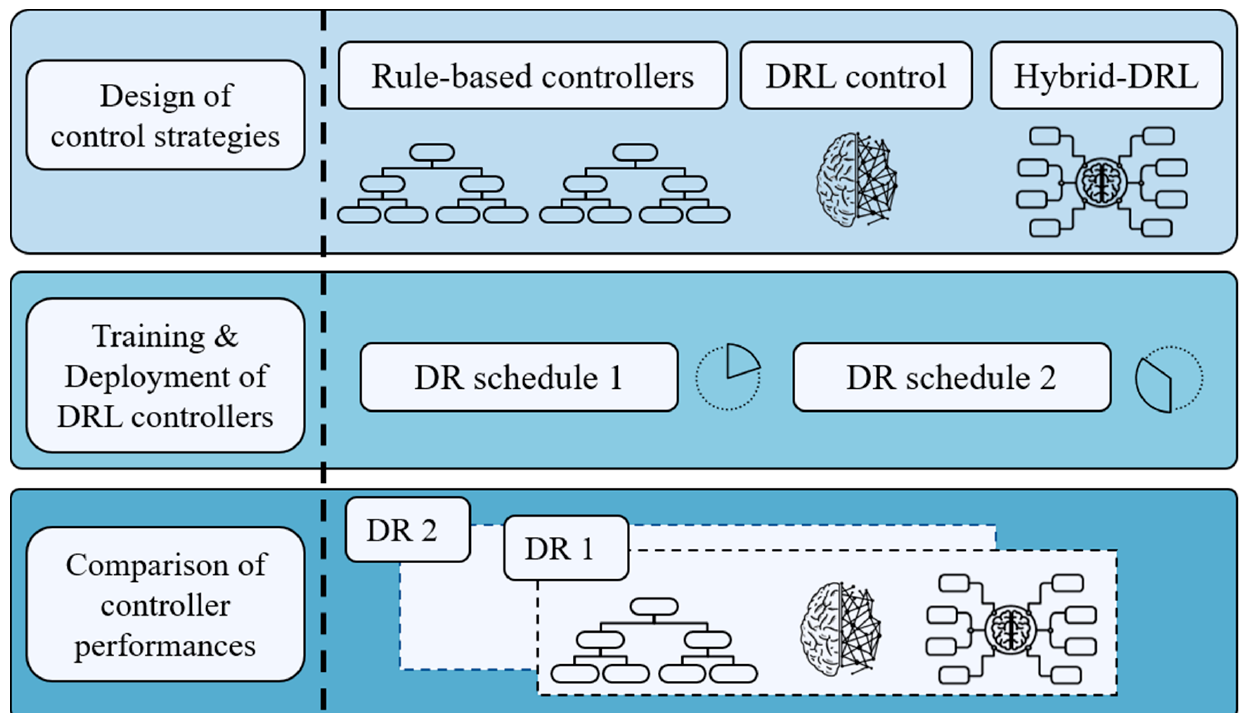
Figure 4. Framework of the application of DRL to demand response.